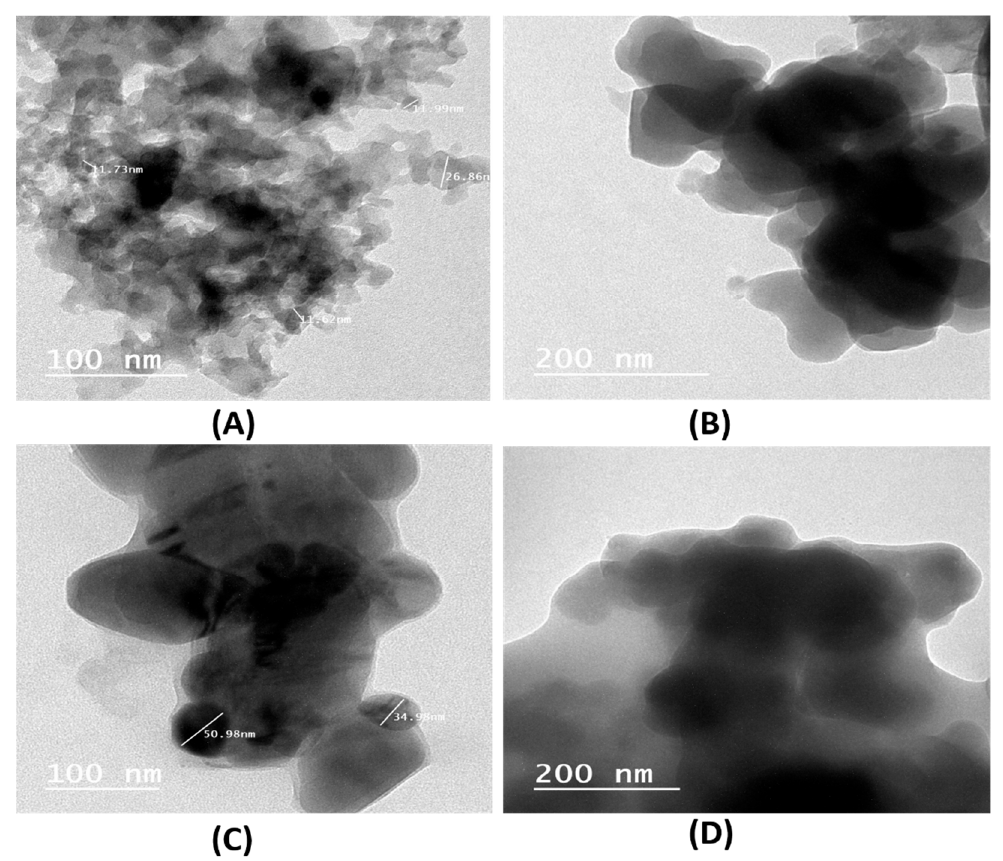
Figure 5. TEM analysis of the SCB nanocomposite ( A ) 100 nm view and ( B ) 200 nm view and the SBDP nanocomposite ( C ) 100 nm view and ( D ) 200 nm view.